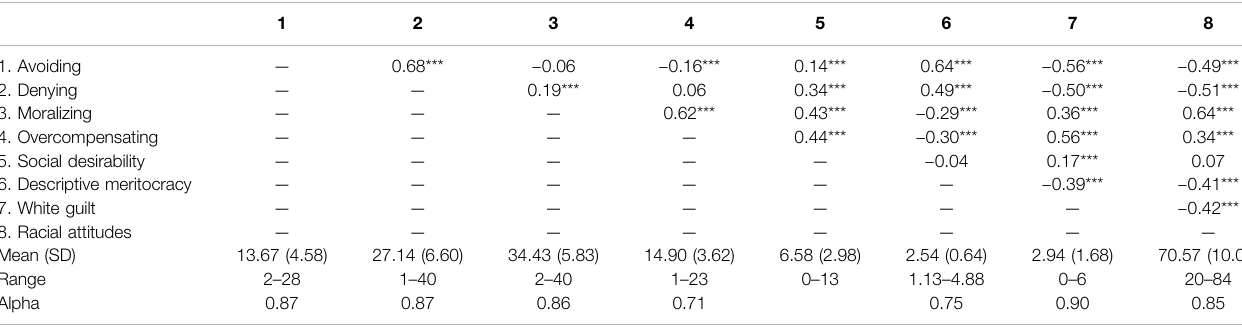
TABLE 4 | Summary data, correlations, and alpha levels for PIE and criterion measures in validation